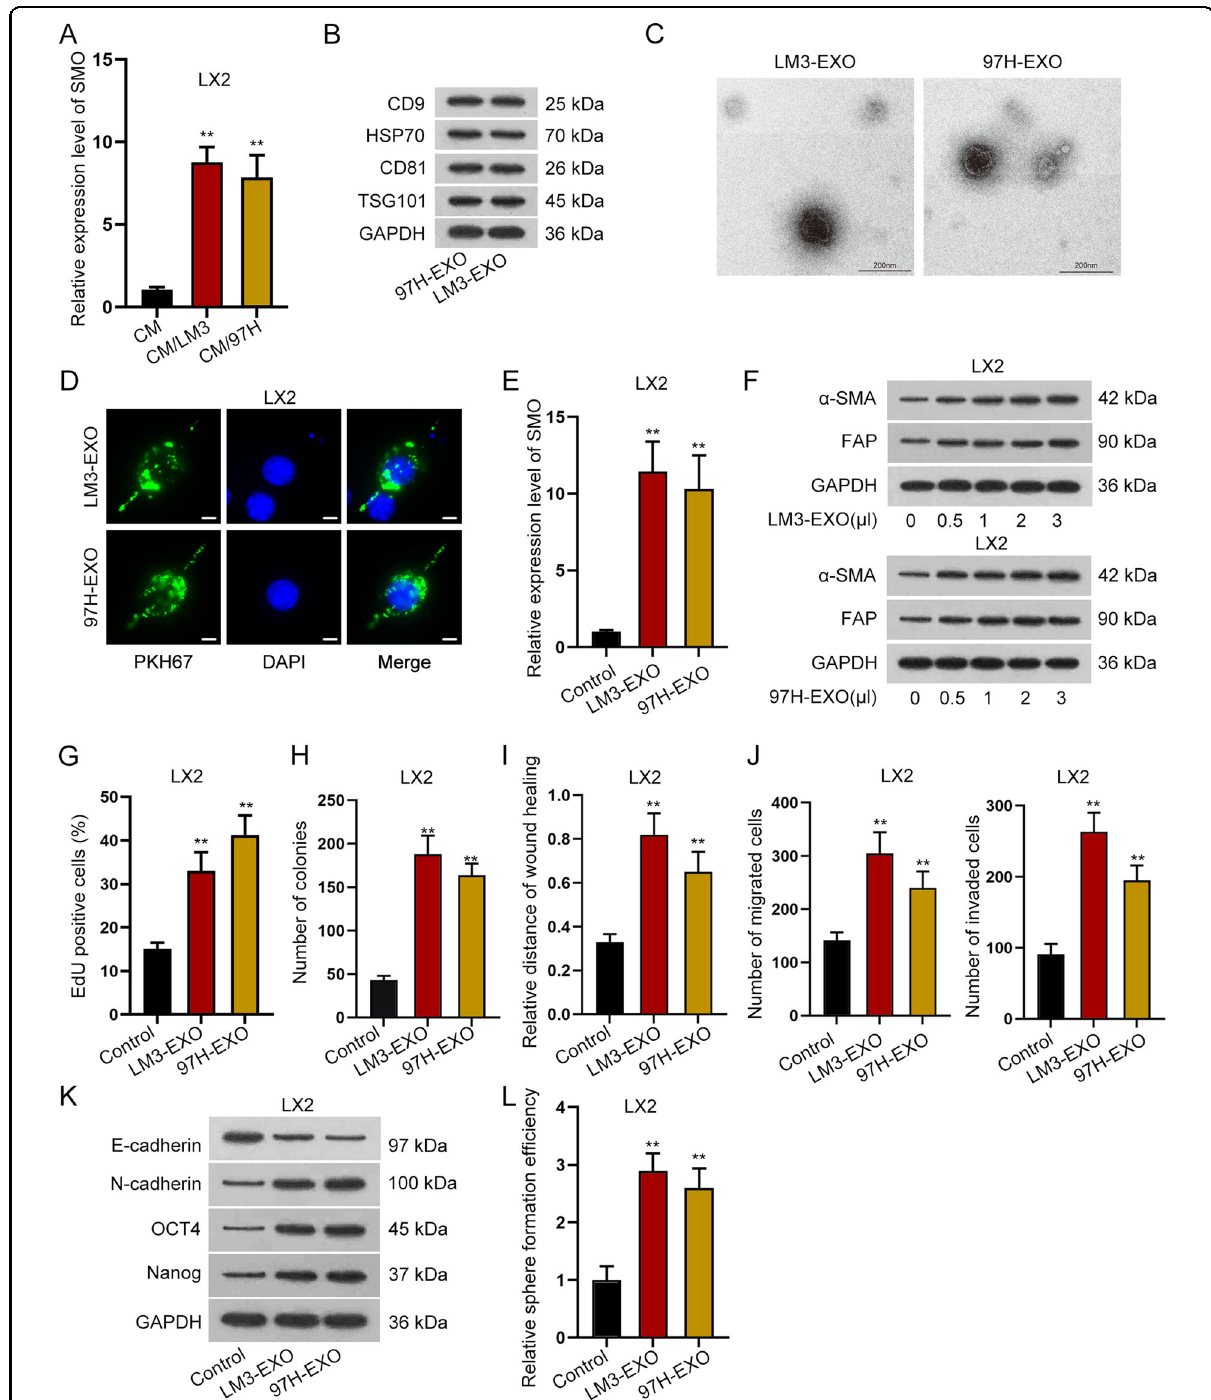
Fig. 2 HCC cells-derived exosomes transmitted SMO and activated HSC. A qRT-PCR detected the expression of SMO in quiescent HSCs and activated HSCs induced by conditioned medium (CM) of LM3 or 97H cells. B Western blot detected the protein level of CD9, HSP70, CD81, and TSG101 in LM3- or 97H-derived exosomes. C Electron microscope revealed the images of exosomes. D IF staining assay revealed PKH67-labeled exosomes in LX2 cells treated with exosomes from LM3/97H cells (bar value = 15 μ m). E qRT-PCR detected the expression of SMO in LX2 cells treated with LM3- or 97H-derived exosomes. F Western blot assay revealed the protein level of α -SMA and FAP in LX2 cells under the treatment of exosomes at different concentrations. G – J EdU, colony formation, wound healing, and transwell assays tested cell proliferation, migration, and invasion in LX2 cells with or without the treatment of LM3 or 97H-derived exosomes. K Western blot analyzed the levels of E-cadherin, N-cadherin, OCT4, and Nanog in quiescent LX2 cells and exosomes-activated LX2 cells. L Sphere formation assay disclosed the effects of LM3- or 97H-derived exosomes on the stemness of LX2 cells. ** P